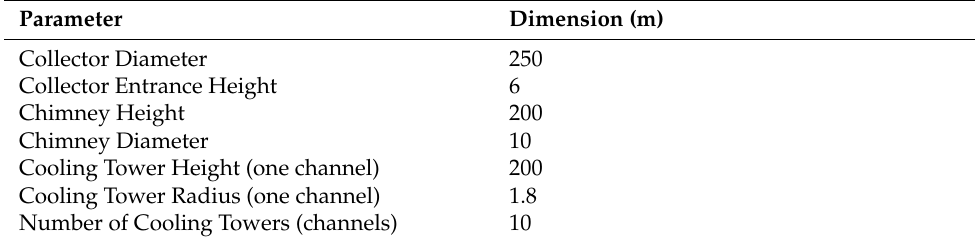
Figure 2. Illustrations of the energy balance equations of the SDCPP. Zone 1 is the solar air heating, and Zone 2 is the solar chimney and cooling tower (CT). Table 1. Dimensions of the SDCPP model.